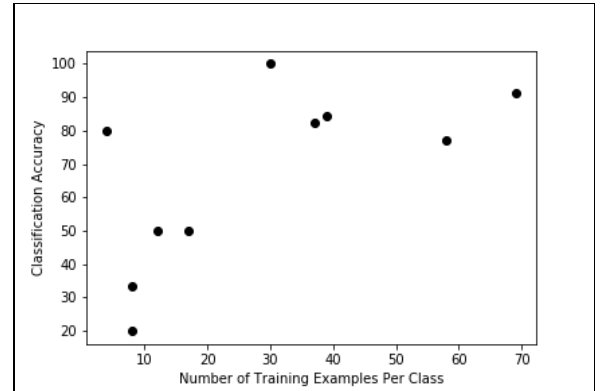
Figure 5. Round 3 experiment classification accuracy vs. number of training examples per